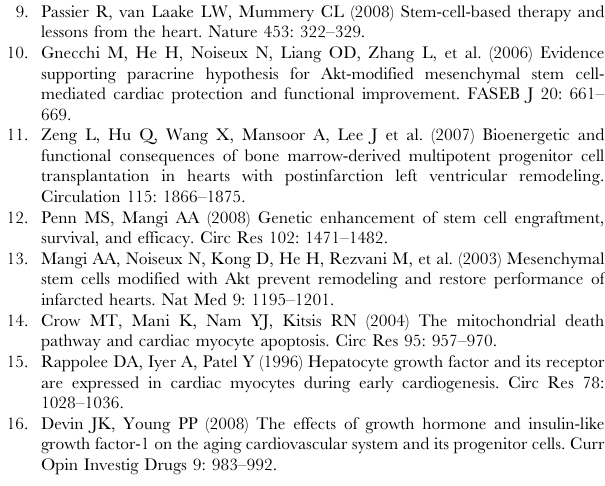
Figure S2 The representative images of Sca-1 + /CD31 2 cells stained with FITC Annexin V and propidium iodide (PI). (A). Selected Sca-1 + /CD31 2 cell population. (B). Dot plot of Sca-1 + /CD31 2 cells stained with PI only. (C). Dot plot of Sca- 1 + /CD31 2 cells stained with FITC Annexin V only. (D). Dot plot of Sca-1 + /CD31 2 cell stained with FITC-Annexin V and PI. (TIF) Figure S3 The representative images of cell cycle analysis with flow cytometry. (A). Sca-1 + /CD31 2 cells cultured in basal medium + 0.5% FBS for 24 hours after 12 hours synchronization. (B). Sca-1 + /CD31 2 cell treated with IGF + HGF in basal medium + 0.5% FBS for 24 hours. (TIF) Figure S4 Schachard plot shows up-regulated and down-regulated genes after Sca-1 + /CD31 2 cell treated with IGF + HGF. Supperarray profiling of 88 growth factor related genes of Sca-1 + /CD31 2 cell and IGF + HGF treated Sca- 1 + /CD31 2 cells. The data is described as having a 4 fold increase or decrease as a scale for determining up-regulation or down- regulation. (TIF) Text S1 Sca-1 + /CD31 – and Sca-1 2 /CD31 2 cell isolation and fluorescence-activated cell sorting analysis. (DOC) Text S2 Animal surgery and cell transplantation. (DOC) Text S3 Echocardiography. (DOC) Text S4 Cell engraftment rates and